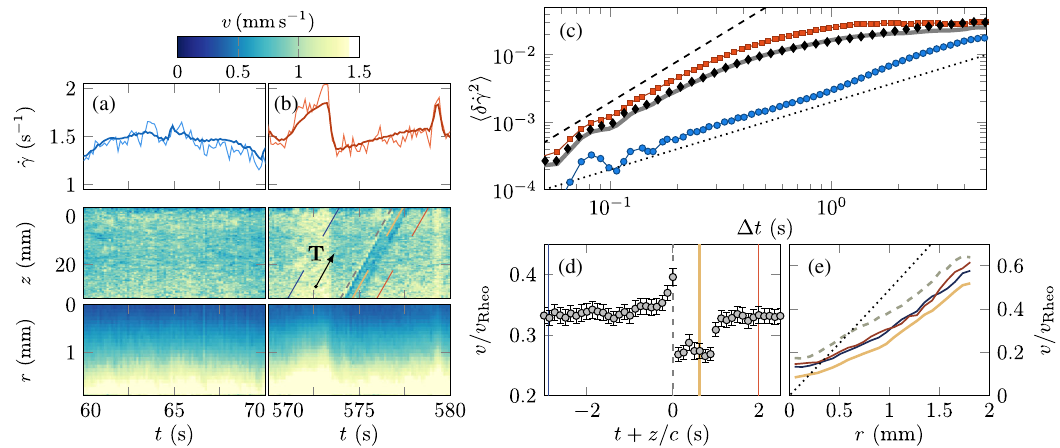
FIG. 4. Spatiotemporal patterns governing the dynamics in regime I ( σ ¼ 12 Pa). (a) Quiesent phase and (b) propagating event. From t Þ inferred from ultrasonic imaging and top to bottom: global shear rate _ γ ð t Þ (thick line) and effective shear rate in the bulk material _ γ B ð rescaled by a multiplicative factor 2.55 (thin line); spatiotemporal maps of the local velocity v ð r; z; t Þ averaged in the r and z directions, respectively. (c) Variance of the shear rate increments as a function of time lag Δ t for the entire time series (black diamonds) together with the variances h δ _ γ 2 (blue circles) and h δ _ γ 2 (red squares) restricted to quiescent phases and to propagating events respectively. The q i p i β h δ _ γ 2 thick gray line is the reconstruction of h δ _ γ 2 i based on a linear combination α h δ _ γ 2 with α ¼ 0 . 82 and β ¼ 0 . 60 . The dotted and q i þ p i t Þ and averaged over dashed lines have slopes 1 and 2, respectively. (d) Local velocity v ð z; t Þ normalized by the rotor velocity v Rheo ð isophases t þ z=c ¼ const along the direction T of band propagation with c ¼ 11 mm s − 1 . (e) Normalized radial velocity profiles v ð r Þ =v averaged at different stages of band propagation along the colored lines indicated in (b) (middle panel) and Rheo